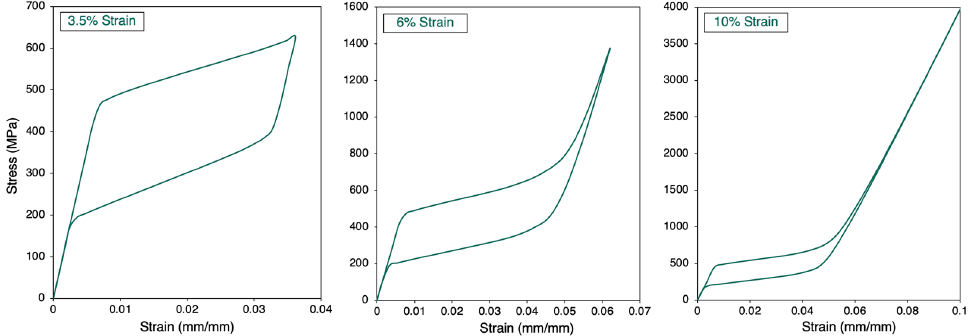
Figure 14. Stress–strain curves for different strain levels: 3.5%, 6%, and 10%.